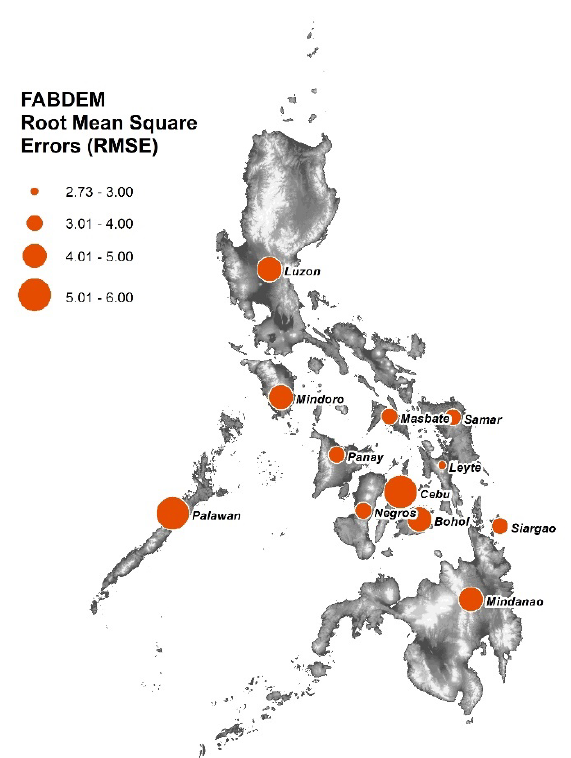
Figure 8. FABDEM RMSEs at selected islands of the Philippines. The values illustrated are the average of the MAE calculated from the three sets of